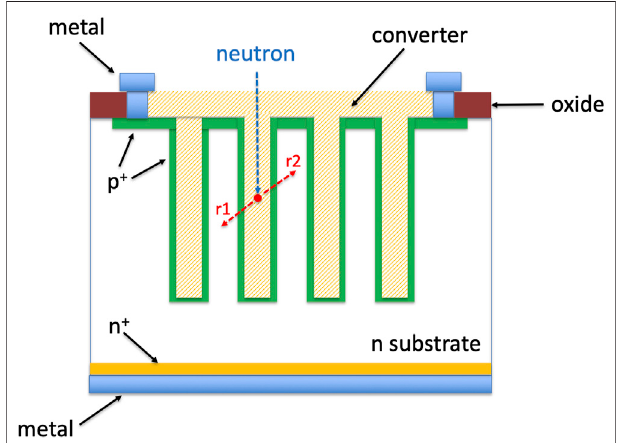
FIGURE 7 | Schematic cross-section of a 3D (microperforated) neutron detectors (r1 and r2 are the reaction products).